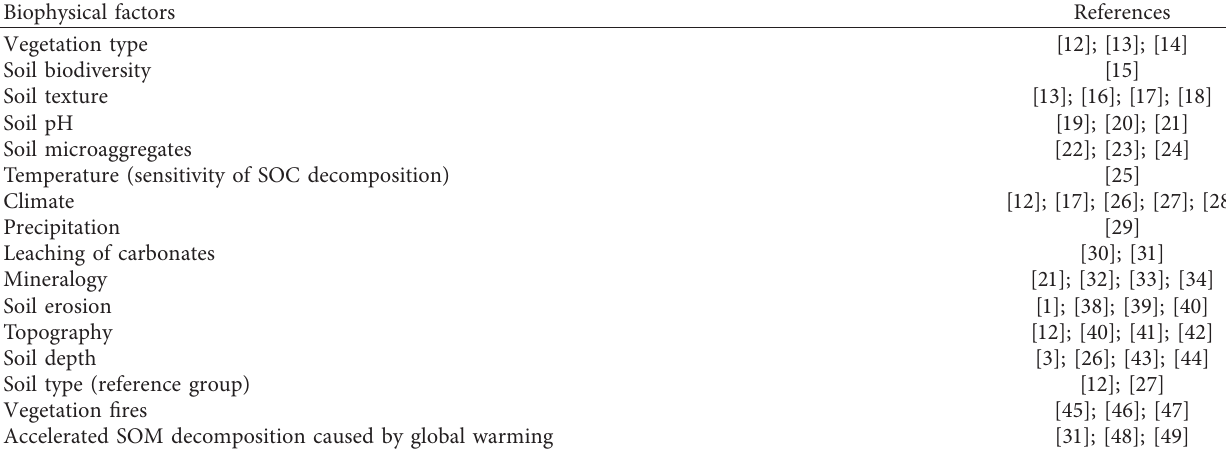
Table 1: Major biophysical factors influencing SOC storage and distribution